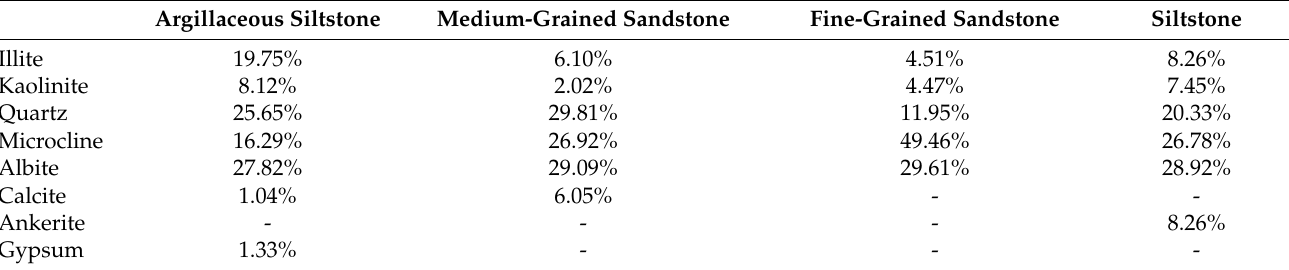
Table 2. Mineral composition of typical reservoir rocks in the Shuang 6 gas